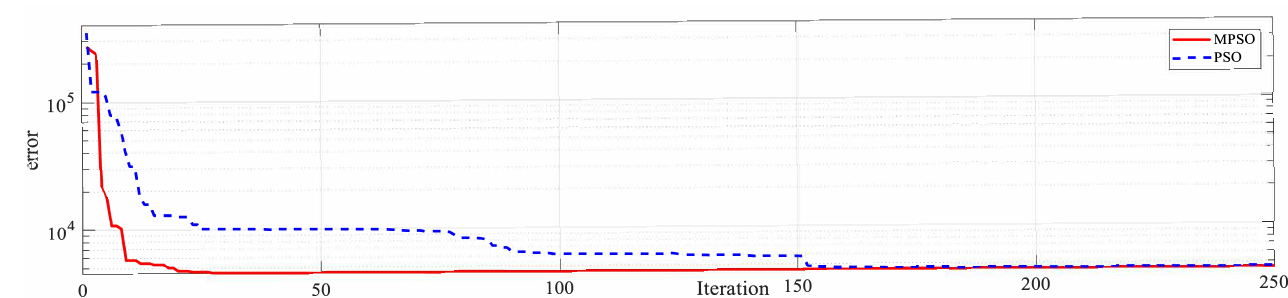
Figure 10. Convergence log.